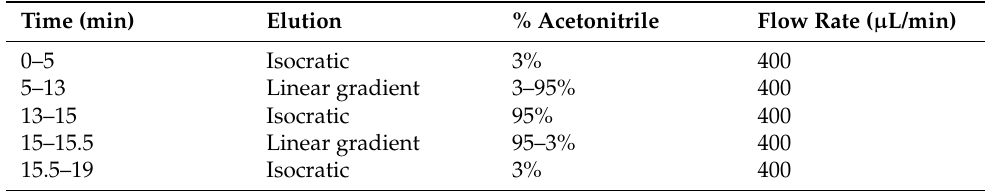
Table 3. Universal gradient elution